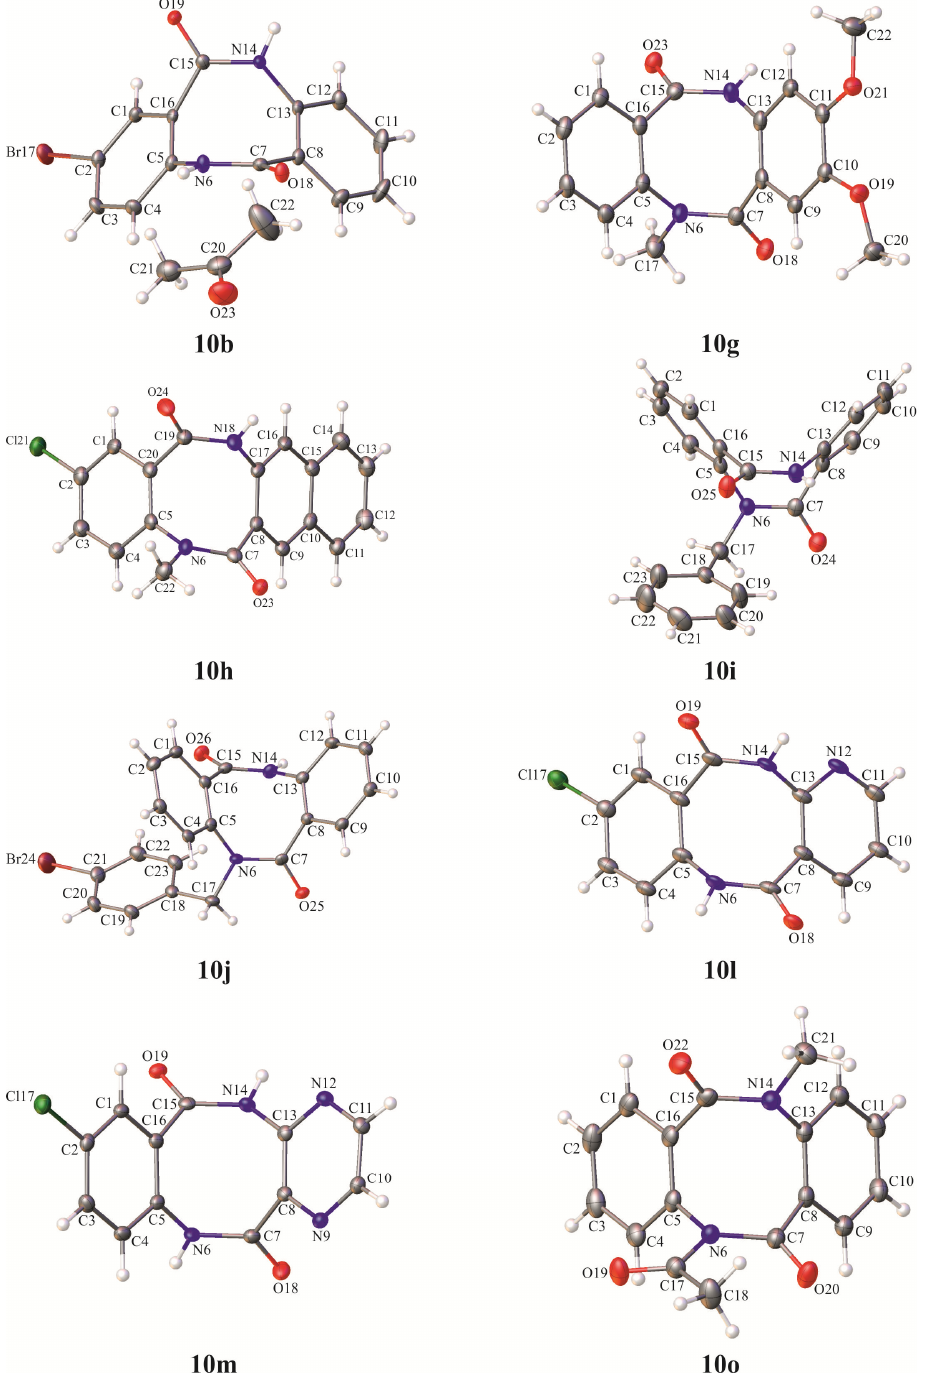
Figure 3. Asymmetric unit of the crystal lattice of final products 10b , 10g – j , 10l , 10m , 10o with crystallographic atom numbering. Displacement ellipsoids are drawn at the 50% probability level. The H-atoms are shown as small spheres of arbitrary radius.